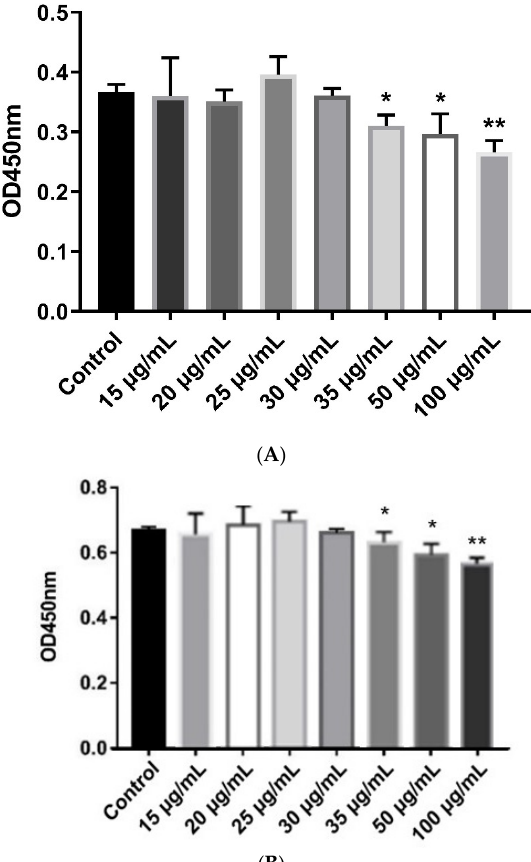
Figure 2. The minimum inhibitory concentration (MIC) assays of recombinant pBD129 protein of E. coli expression system. ( A ) The MIC of recombinant pBD129 protein against E. coli DH5 α was 35 µg/mL. ( B ) The MIC of recombinant pPBD129 protein against Streptococcus dysgalactiae was 35 µg/mL. Data are presented as the mean± SEM, n = 3. * p < 0.05, ** p < 0.01.